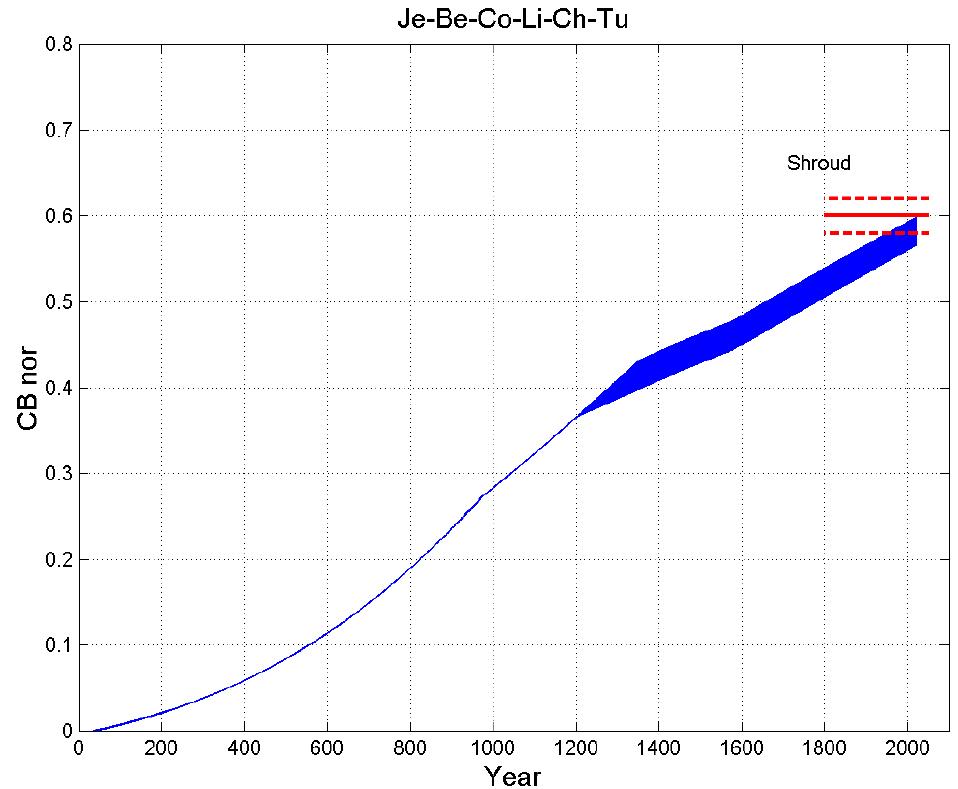
Figure 5. CB nor versus year in the Jerusalem–Beirut–Constantinople–Lirey–Chamb é ry–Turin path (Tables 1 and 2, Figure 1) until the year 2021. Each curve assumes a different arrival year in Europe, t Eu , randomly generated from a uniform distribution in the interval 1204 ≤ t Eu ≤ 1354. The upper curve assumes t Eu = 1354, while for the lowest curve t Eu = 1204. In 2021, CB nor , min = 0.566, CB nor , max = 0.598, and CB nor , ave = 0.582. The continuous red line indicates the average experimental CB nor = 0.60 measured for the Shroud [9]; the dashed red lines indicate ± 1 standard deviation bounds due to measurement uncertainty.